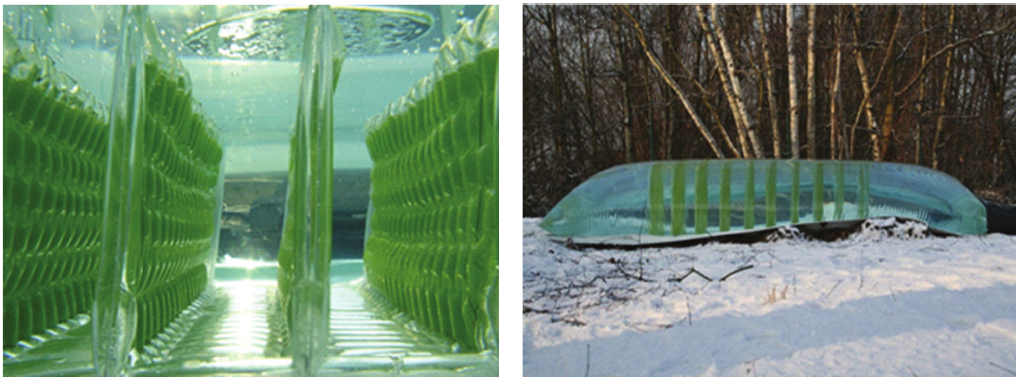
Figure 4: Submerged flat panels in a Proviron photobioreactor